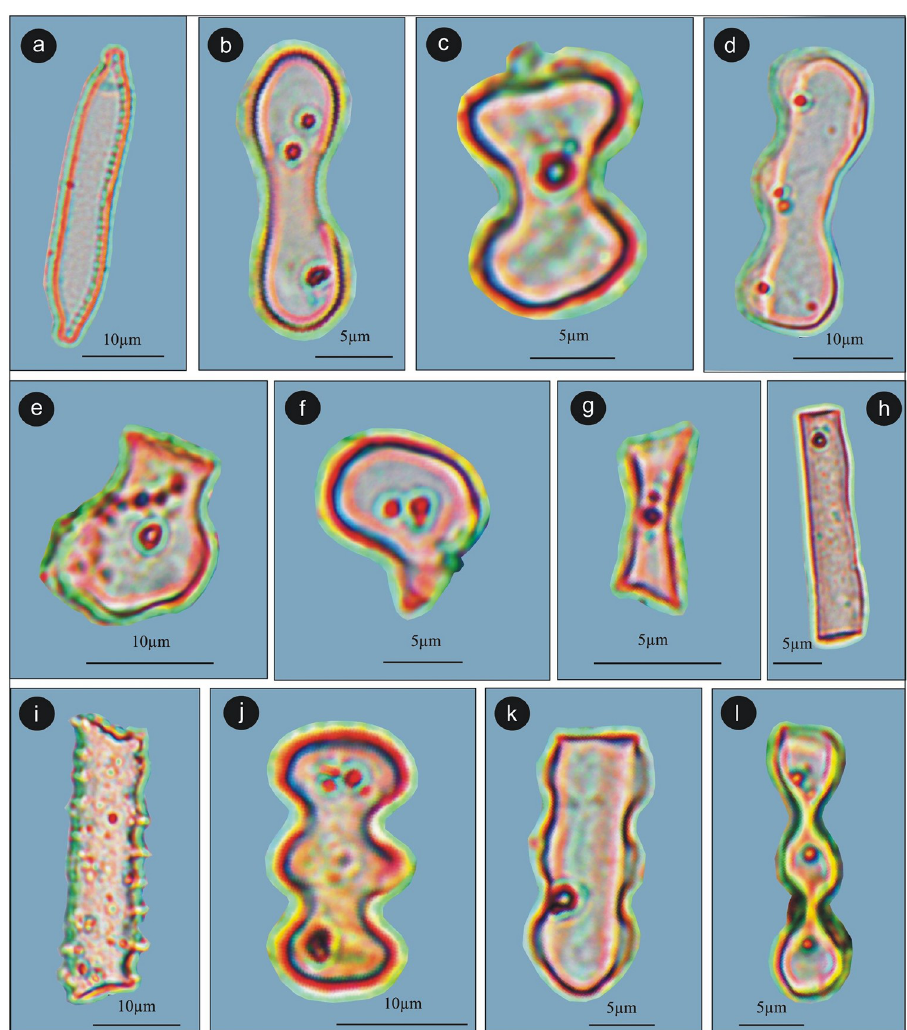
Fig 5. Diatom and phytoliths assemblage of the studied samples. a. Hantzschia , b. Dumbel bilobate, c. Bilobate short cell, d. Wavy, e. Cuneiform Bulliform cell, f. Bulliform, g. Rondel, h. Elongated smooth long cell, i. Elongated echinate long cell, j. Polylobate, k. Polylobate, l. Cylindrical